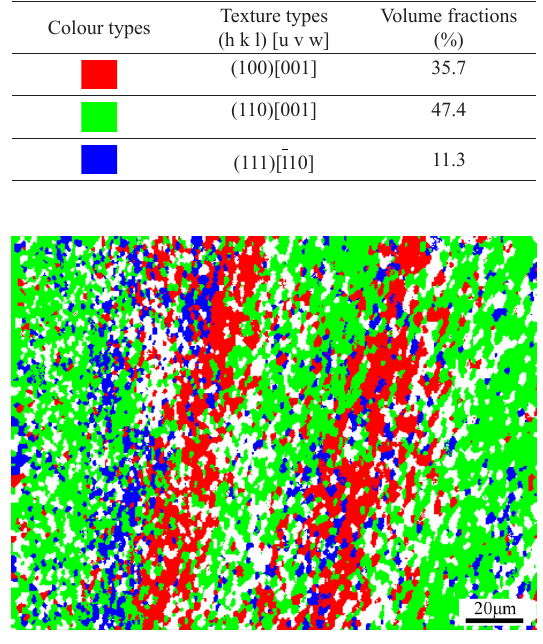
Figure 10. Distribution of grains of various